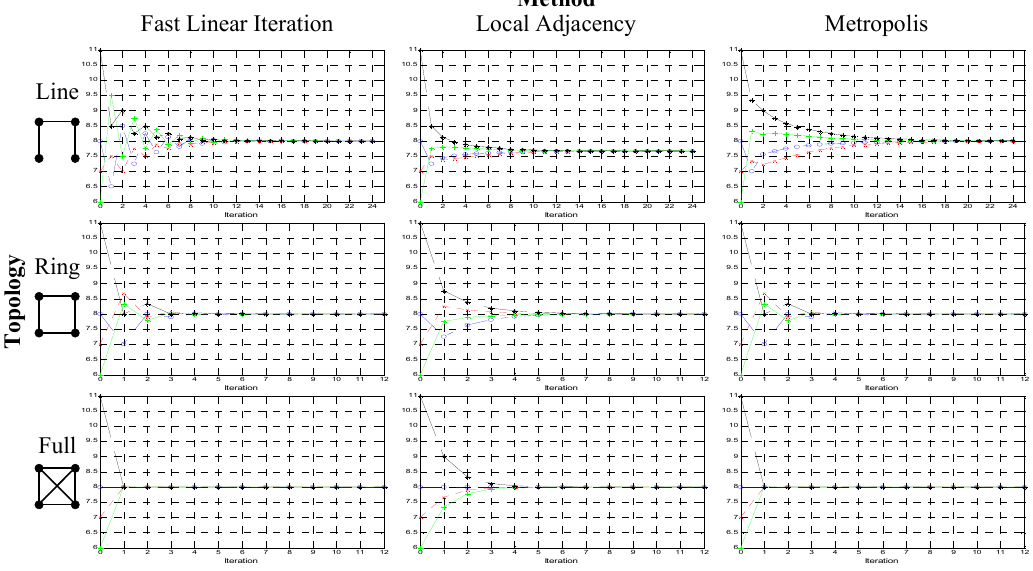
Figure 1. Convergence characteristic according to the weighted factor selection method and the network topology.